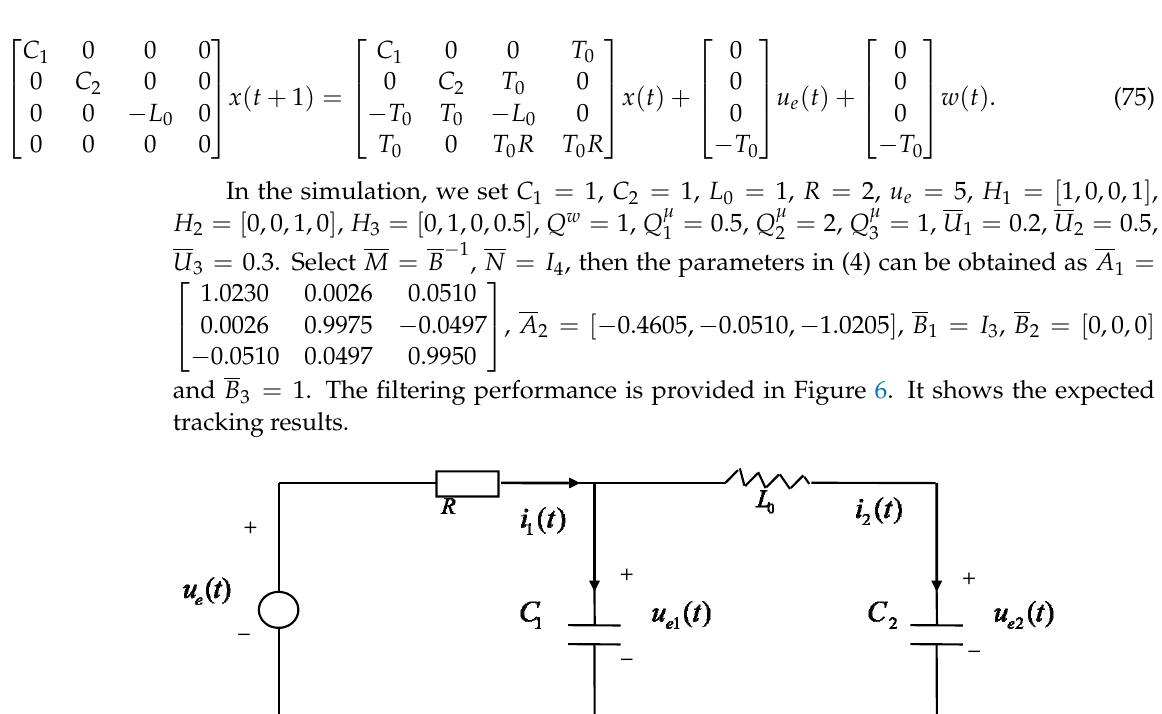
Figure 6. Tracking performance of DFFWF. ( a ) The voltage of C 1 . ( b ) The voltage of C 2 . ( c ) The